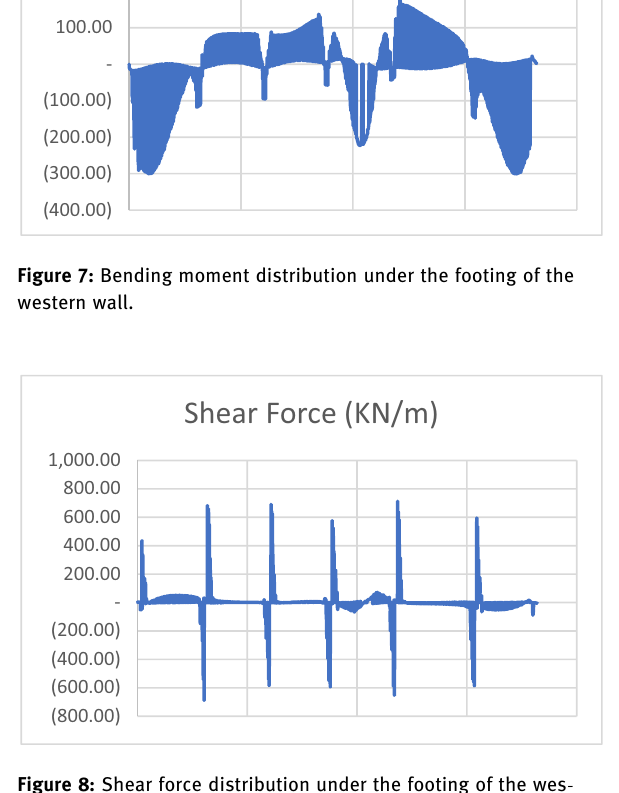
Figure 8: Shear force distribution under the footing of the wes - tern wall.